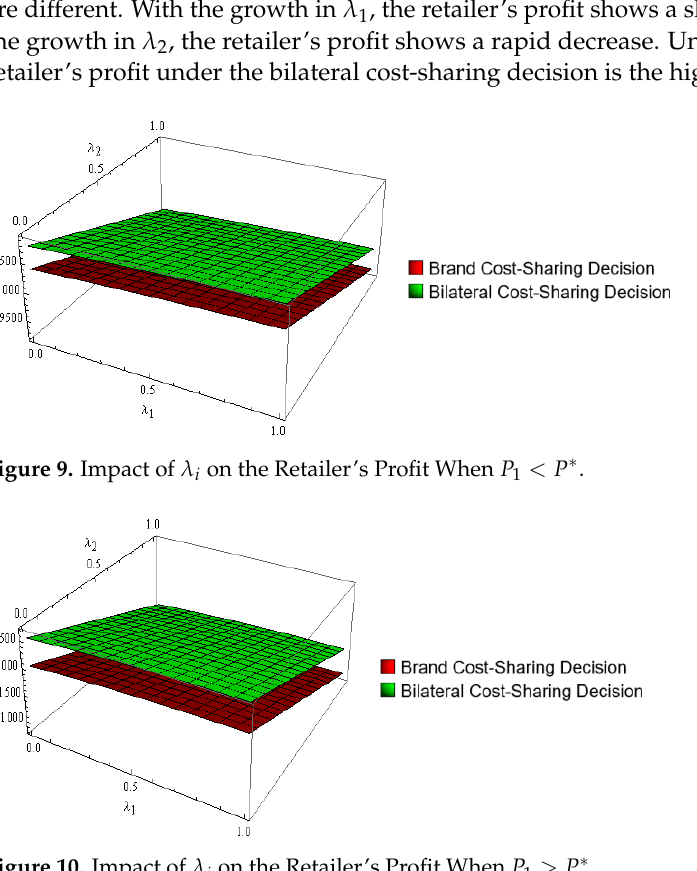
Figure 10. Impact of